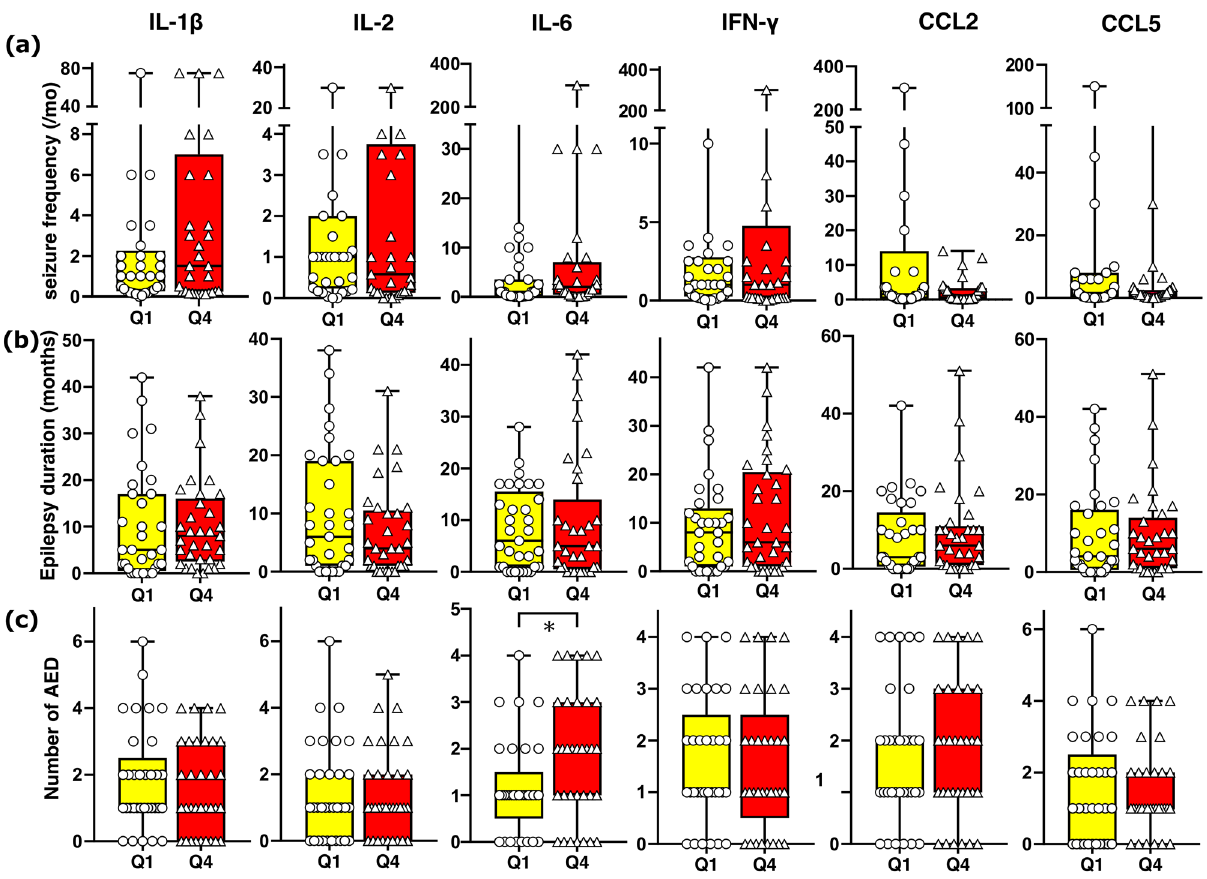
Figure 3. Seizure frequency, disease duration, and the number of AEDs and cytokines. We compared seizure frequency, disease duration, and the number of AEDs of lower (Q1) and upper quartile (Q4) of IL-1β, IL-2, IL-6, IFN-γ, CCL2, and CCL5. There was no significant difference in seizure frequency between Q1 and Q4 of IL-1β, IL-2, IL-6, IFN-γ, and CCL5, except on CCL2, seizure frequency was lower in Q4 ( p -value = 0.039). The disease duration was longer in Q4 of IL-6 ( p -value = 0.018). There was no significant difference of AED numbers between Q1 and